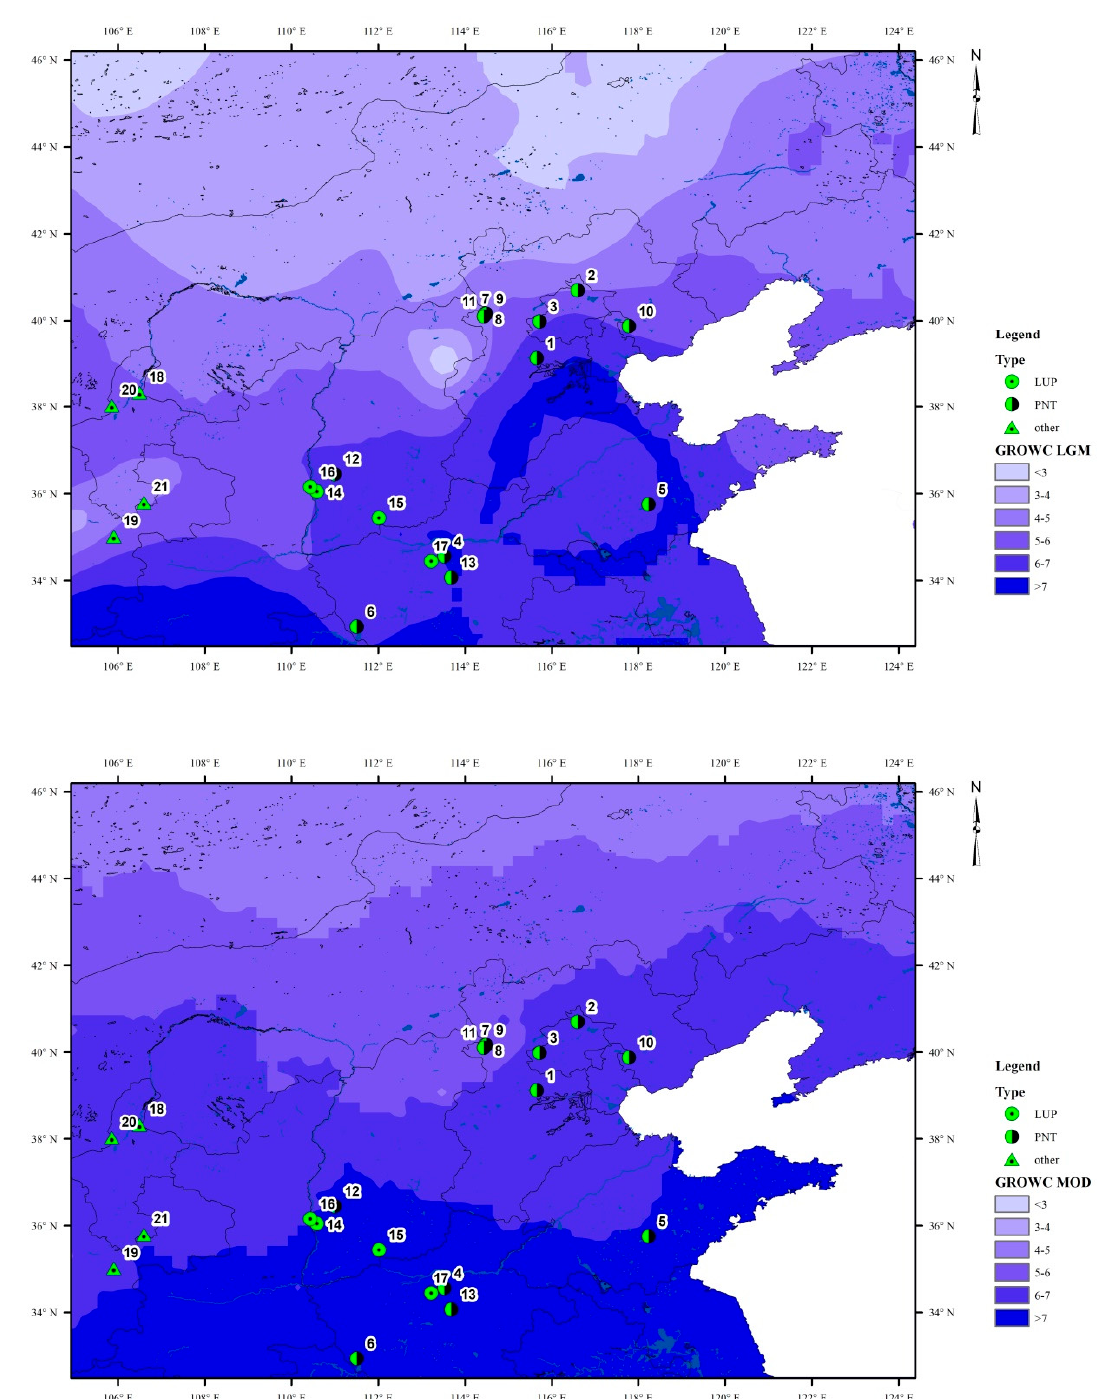
Figure 3. Archaeological sites dated to the Pleistocene to Holocene transition on the maps of growing season (GROWC) of Northern China under LGM and modern climatic conditions.